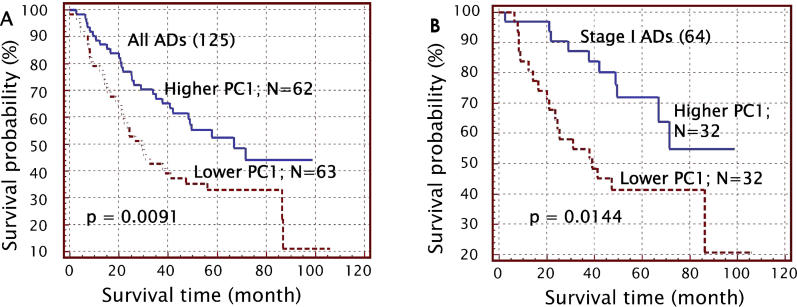
Survival Analyses of AD Patients Based on Lung Development AssociationSurvival analyses of lung AD patients based on their mouse lung genomic PC1 coordinate show significant survival time differences between samples with early PC1 coordinates versus samples with later PC1 coordinates. The lung development genomic framework is constructed from 472 genes that are significantly up- or down-regulated in AD, SQ, or SCLC subtypes from among the set of 596 significant genes (i.e., excluding COID significant genes).(A) K-M plot for 125 AD patients separated into two quasi-equal-sized groups at the median (50th percentile) by their mouse lung genomic PC1 coordinate (
p = 0.0091).
(B) K-M plot for 64 stage I AD patients separated into two equal-sized groups at the median by their mouse lung genomic PC1 coordinates (
p = 0.0144). These 64 stage I AD patient samples are selected for having more than 40% tumor cellularity, no mixed histology (adenosquamous), and patient survival information; the same criteria were described in Beer et al. [
21].